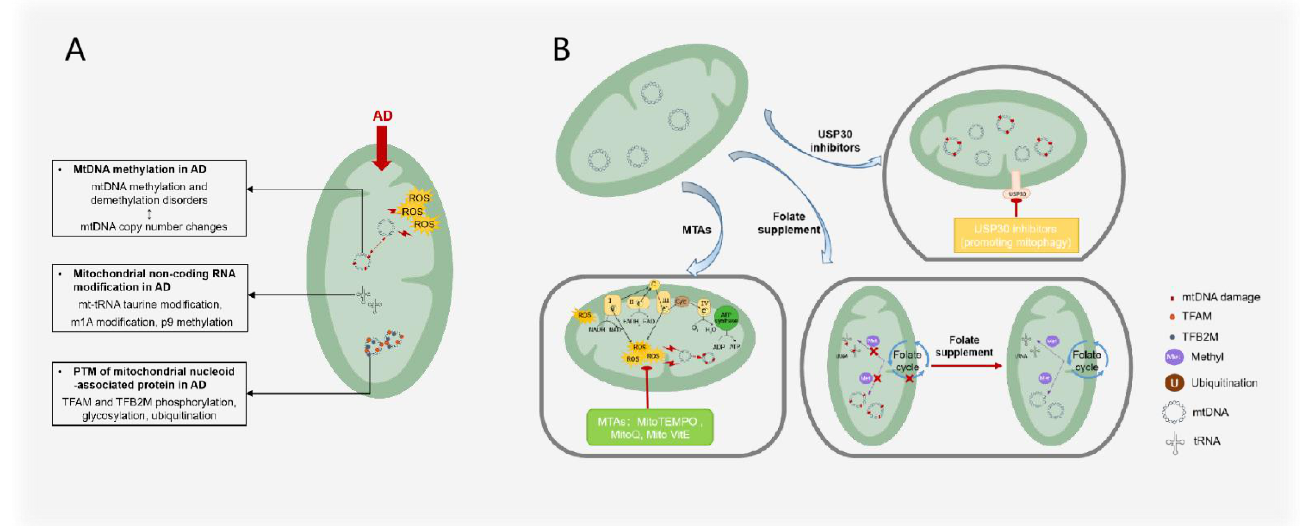
Figure 5. AD treatments and mechanisms that target mitochondrial epigenesis. ( A ) Mitochondrial epigenetic changes observed in AD mainly include the imbalance of mtDNA methylation and demethylation; tRNA taurine modification, m1A modification, and p9 methylation; phosphorylation, glycosylation, and ubiquitination of mitochondrial nucleoid proteins such as TFAM and TFB2M. mtDNA methylation and demethylation imbalance is correlated with mtDNA copy number changes. ( B ) AD treatment targeting mitochondrial epigenetics mainly includes the use of mitochondria-targeted antioxidants to reduce ROS damage to mtDNA, the use of folic acid supplements to maintain the methylation balance between mtDNA and RNA, and USP30 to inhibit the adverse ubiquitination of mitochondrial proteins.